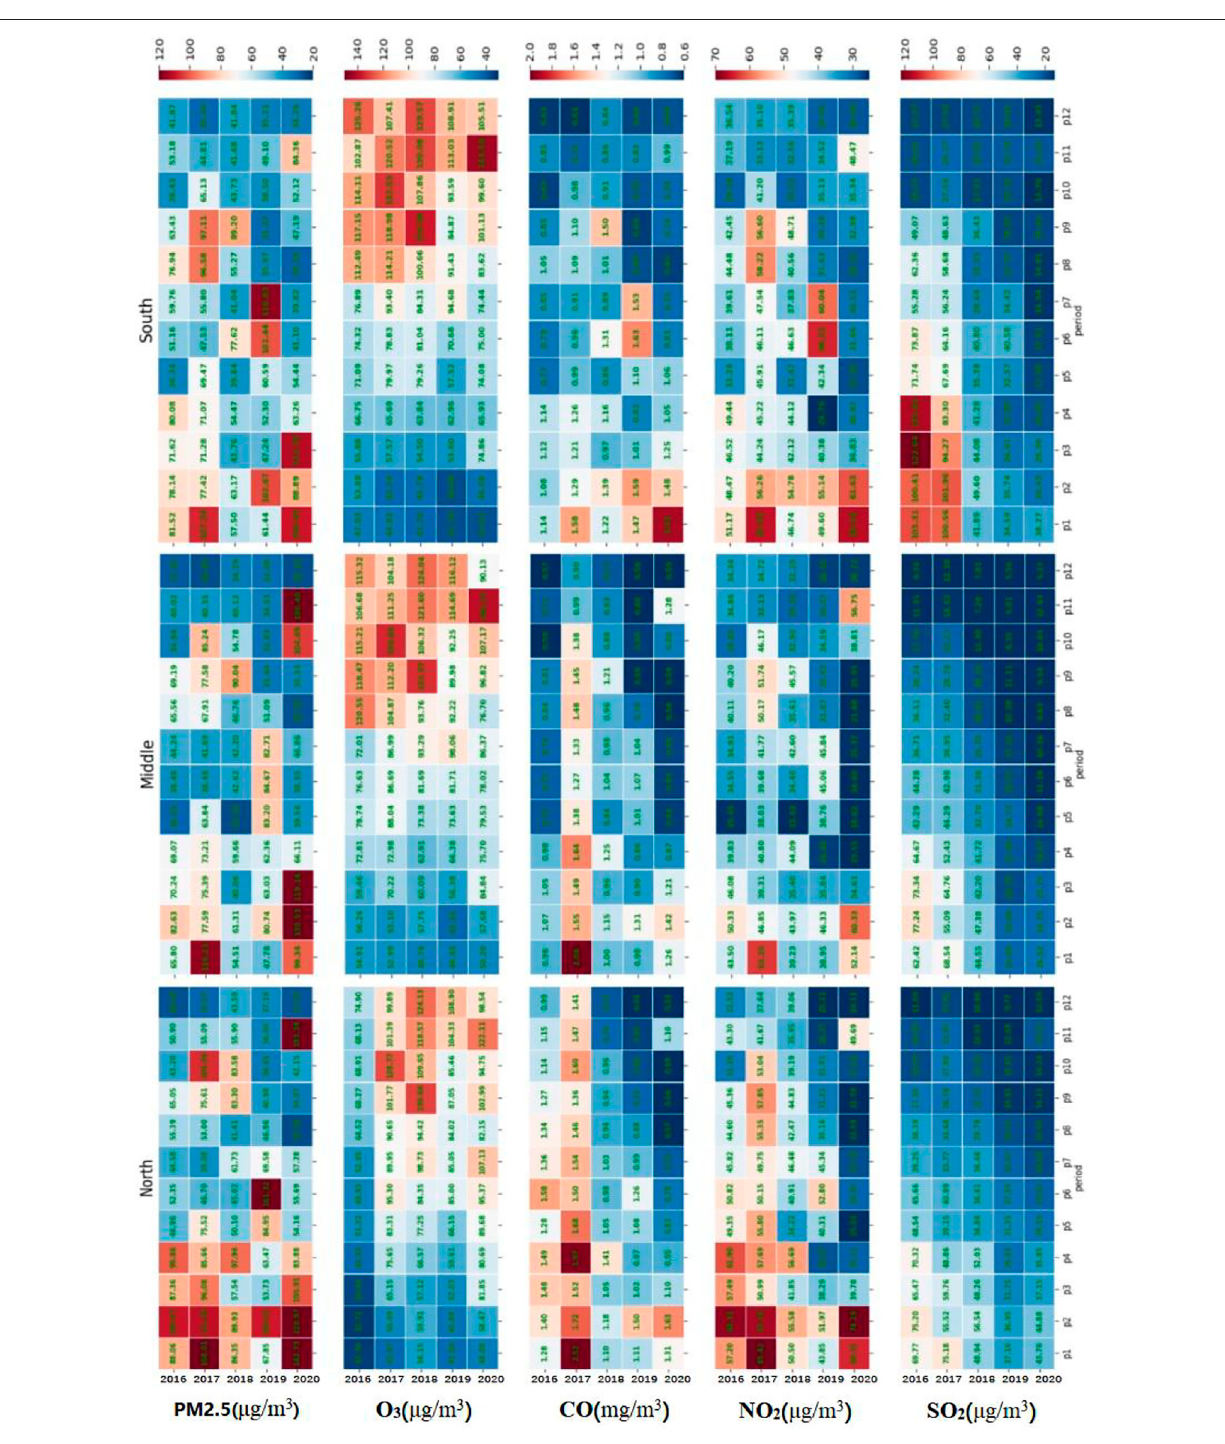
FIGURE 7 | Heat map of the changes in the concentration of the fi ve main pollutants during the SP. The north is Harbin, the middle is Changchun, and the south is Shenyang. The green numbers indicate the average pollutant concentration.